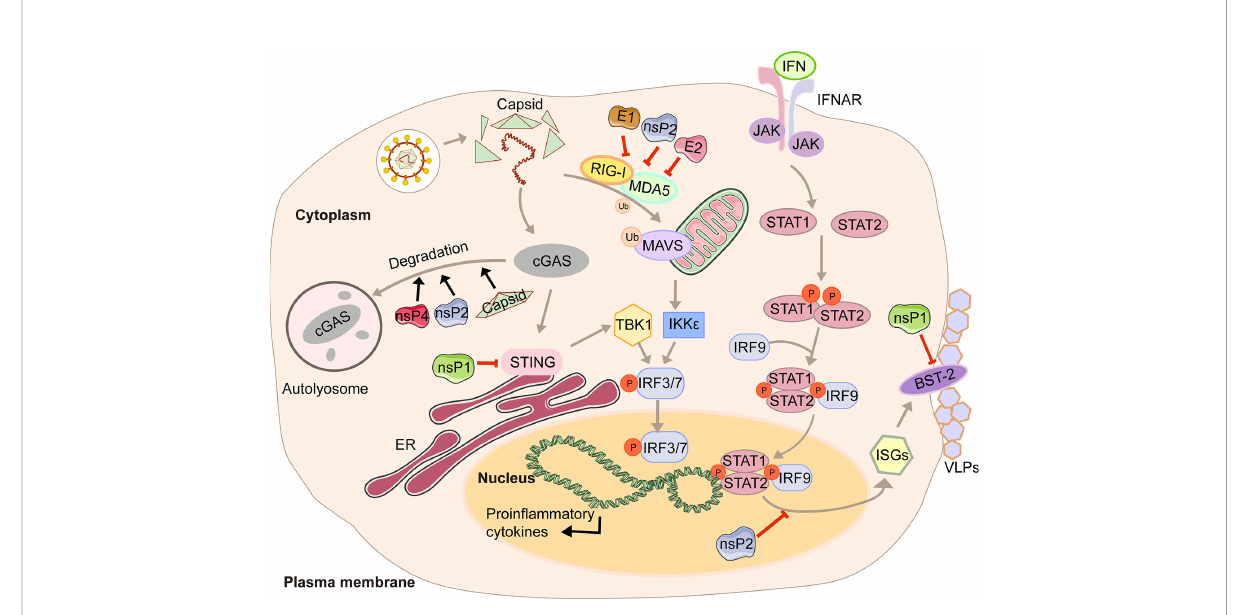
FIGURE 1 A diagram of alphavirus-mediated inhibition of the innate immune pathways leading to the production of IFN and ISG